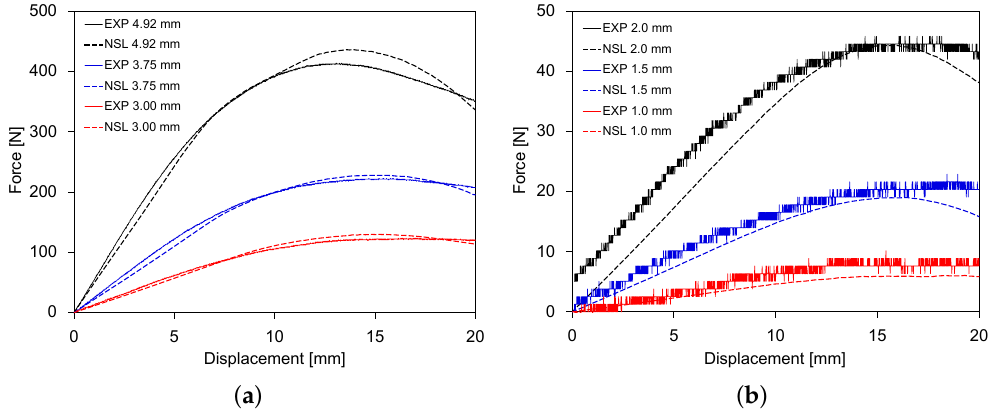
Figure 4. Force-displacement curves obtained in the three-point bending of polycarbonate beam for six different thicknesses: experimental data (EXP) and numerical simulations (NSL).